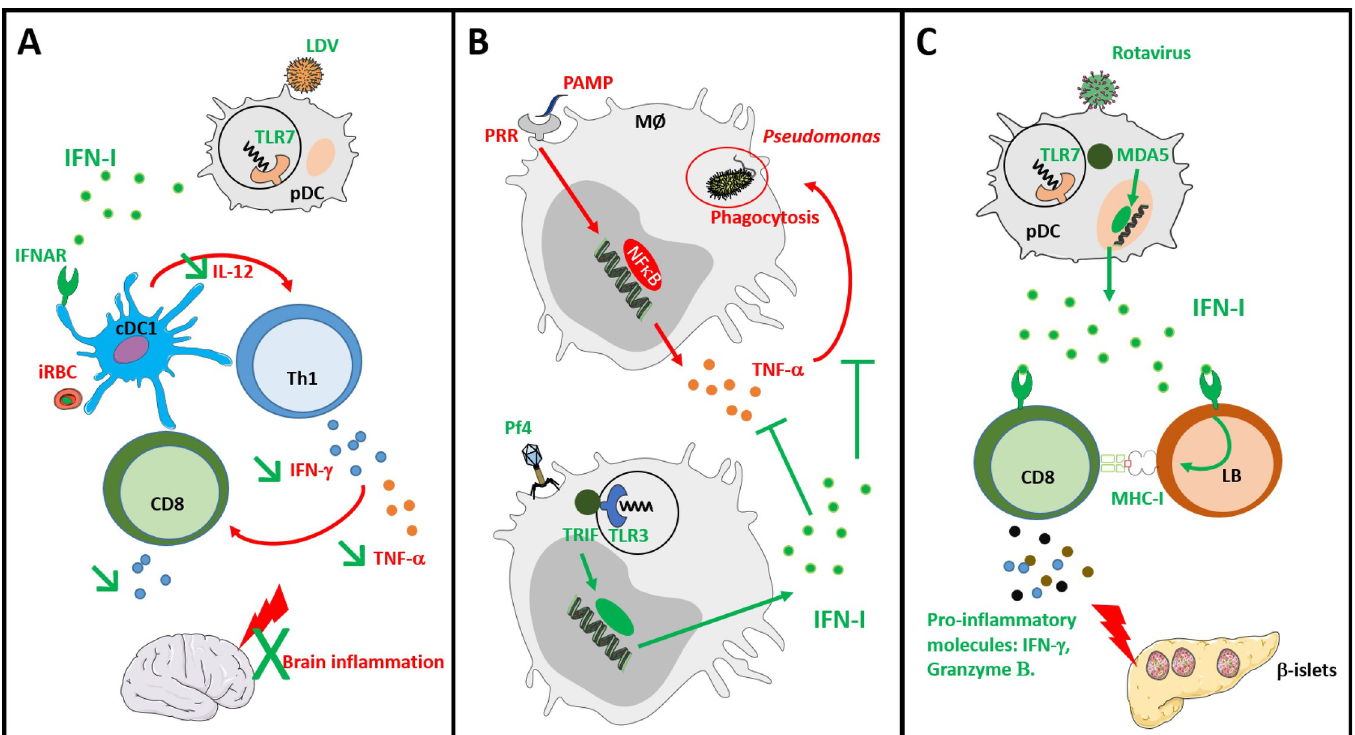
Fig 2. Examples of immunomodulation through infection-mediated IFN-I. IFN-I display high modulatory potential as illustrated by their capacity to positively or negatively modulate infectious or autoimmune diseases and to shape the functions of innate and adaptive immune cells. (A AU : Pleasecheckandconfirmthattheeditstothesentence ð A Þ DCspresentparasiticantigenstoTcells ; whichinduce ::: didnotaltertheintendedthethoughtofthesentence : ) DCs present parasitic antigens to T cells, which induces cell migration to the brain and proinflammatory cytokine production causing cerebral malaria. LDV infection induces IFN-I production by pDC. Released IFN-I causes a quantitative and qualitative defect in DC and, consequently, a decreased inflammatory response leading to the protection against cerebral malaria. (B) Bacterial ligands stimulate NF- κ B translocation leading to TNF- α production. TNF stimulates bacterial phagocytosis by macrophages. Phage RNA triggers IFN-I production through TLR3-mediated TRIF signaling. IFN-I inhibits TNF production and bacterial phagocytosis and prevents infection clearance. (C) Rotavirus RNA induces IFN-I by pDC through TLR7/MDA5 signaling. IFN-I induces lymphocyte activation, B cells up-regulate MHC-I expression and present autoantigens to CD8+ T cells, which, in turn, produce proinflammatory molecules and cause death of pancreatic β cells. (IFN-I production and modulatory functions are presented in green). DC, dendritic cell; IFN-I, type I interferon; LDV, lactate dehydrogenase-elevating virus; pDC, plasmacytoid DC; TNF, tumor necrosis